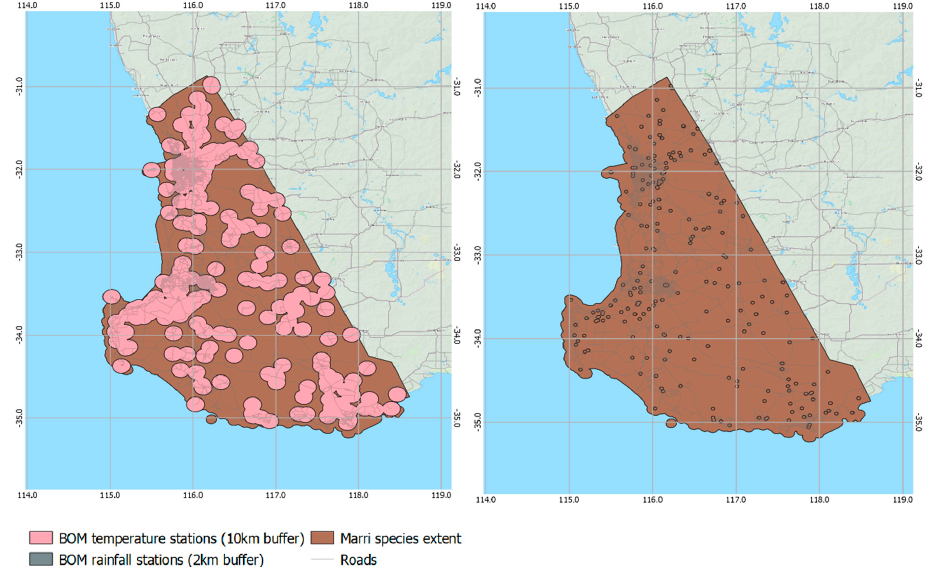
Figure 4. Coverage of Bureau of Meteorology (BOM) rainfall and temperature weather stations over the geographic extent of marri trees. Coordinates are in WGS84.